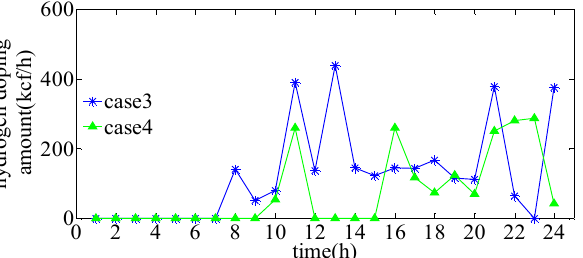
Figure 8. Comparison of the amount of hydrogen mixed in Case 3 and Case 4. In the figure, the blue curve drawn by asterisk connection represents the amount of hydrogen mixed in Case 3; the green curve drawn by triangle connection represents the amount of hydrogen mixed in Case 4.